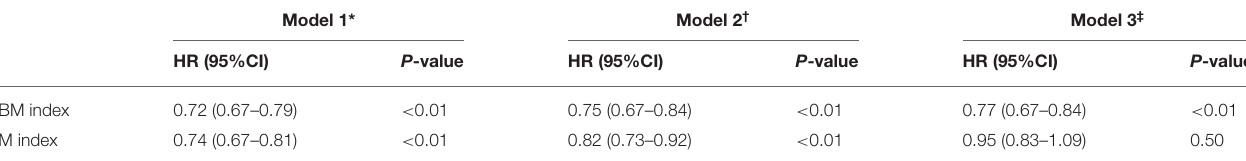
TABLE 4 | Hazard ratios (HR) for 1-year mortality of HF patients according to a 1-SD increase in LBM index and FM index.